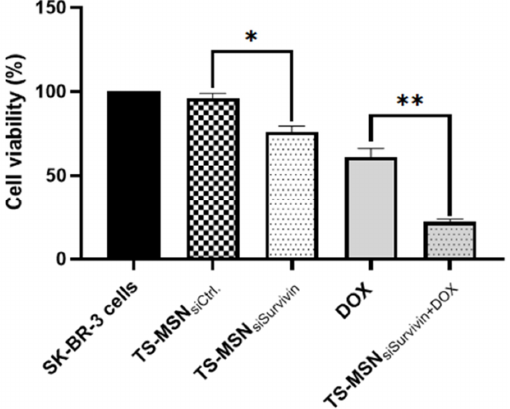
Figure 10. SK-BR-3 cells’ viability after treatment with the combination of TS-MSN and DOX. TS- MSN were formulated either with Ctrl. siRNA or anti-Survivin siRNA and were incubated at a